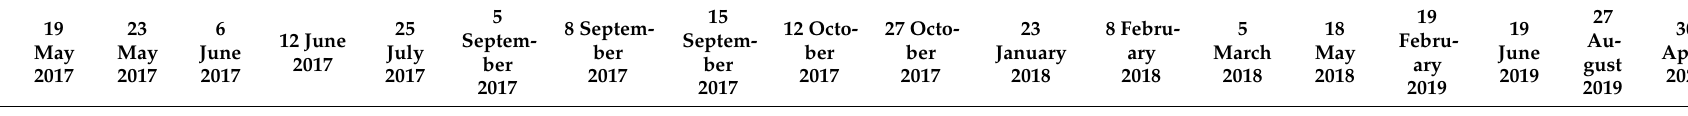
Table 1. Results of bronchoalveolar lavages (BALs) and sputum analysis from May 2017, to April 2020, in 12-year-old lung transplanted patient who received two rounds of phage therapy for pandrug-resistant Achromobacter xylosoxidans colonization and